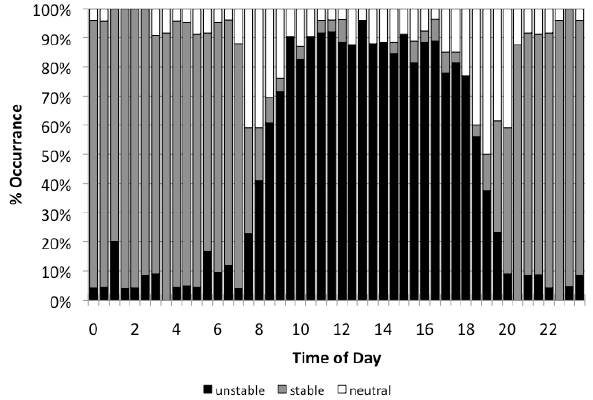
Figure 4. Diel plot of percent occurrence of stability class (unstable, stable, neutral) for 816 Fig. 4. Diel plot of percent occurrence of stability class (unstable, each 30-­‐minute period during the CABINEX campaign (10 July-­‐ 8 August 2009; 27 total 817 stable, neutral) for each 30-min period during the CABINEX cam- days with 1152 total 30-­‐minute periods after filtering). Stability classification is based 818 paign (10 July–8 August 2009; 27 total days with 1152 total 30-min periods after filtering). Stability classification is based on Obukhov on Obukhov length (Section 2.2). 819 length (Sect.